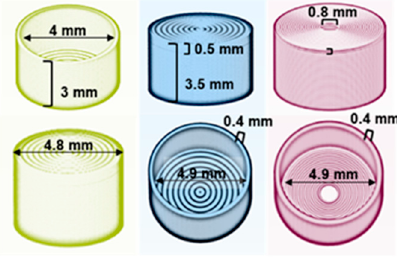
Figure 3. Key feature dimensions for fused deposition modeling (FDM)-printed submodular components, i.e., cup (left), soluble lid (middle), and insoluble lid (right), viewed upright (top row) and inverted (bottom row).